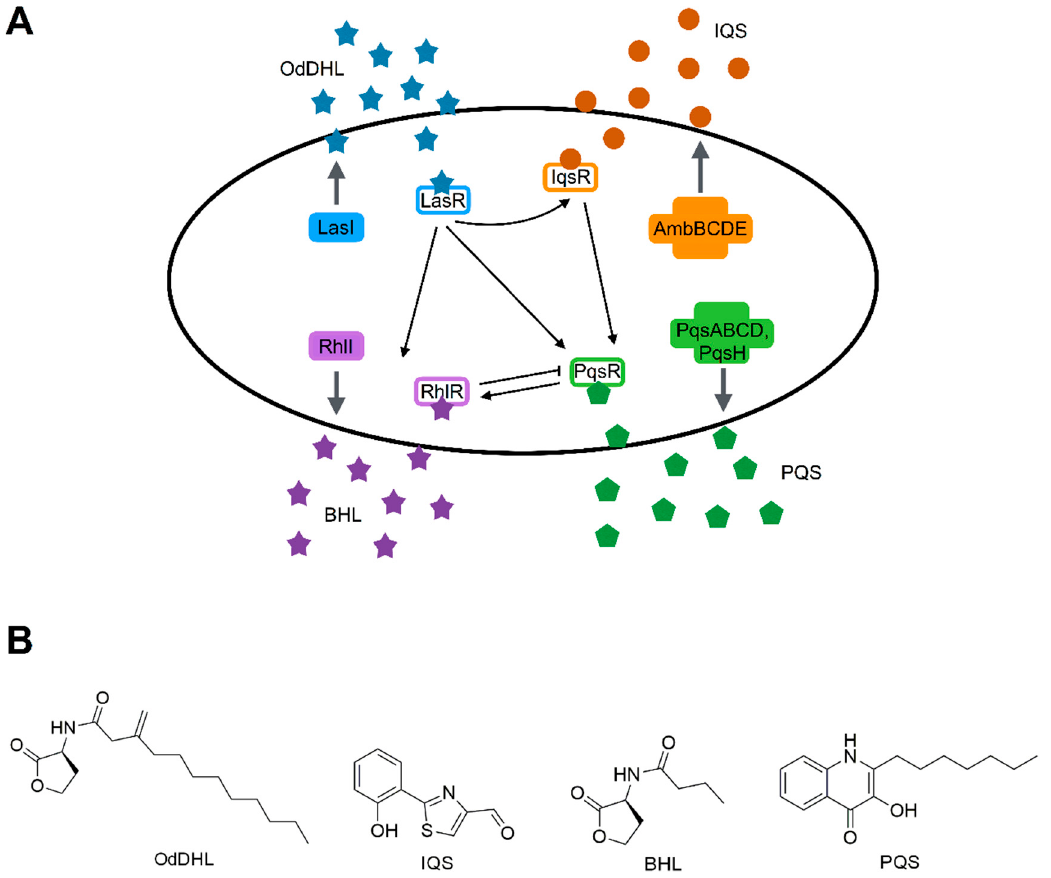
Figure 4. The QS systems of P. aeruginosa , Las, Iqs, Rhl and Pqs and their interactions. ( A ) OdDHL, N -(3-oxododecanoyl) homoserine lactone; IQS, integrating quorum sensing signal; BHL, N -butyryl- L -homoserine lactone; PQS, Pseudomonas quinolone signal. Arrows indicate positive regulation, T-bars negative regulation. ( B ) Chemical structures of QS signal molecules.